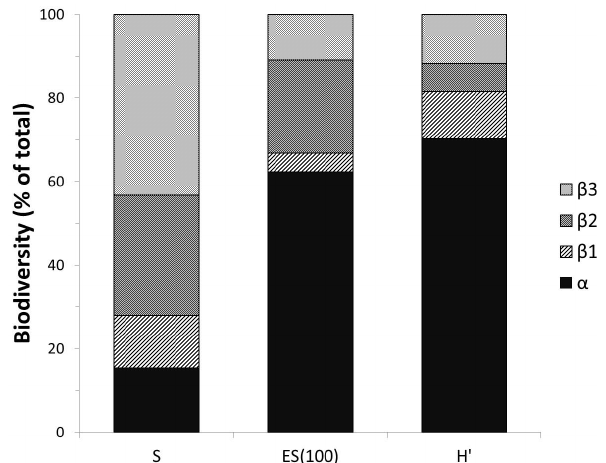
Fig. 8. Partition of diversity for different indices. S : number of species; ES ( 100 ) : Hurlbert expected number of species per 100 indi- viduals; H 0 : Shannon–Wiener diversity (ln-based). β 1 : β -diversity within mud volcanoes; β 2 : β -diversity between mud volcanoes; β 3 : β -diversity between